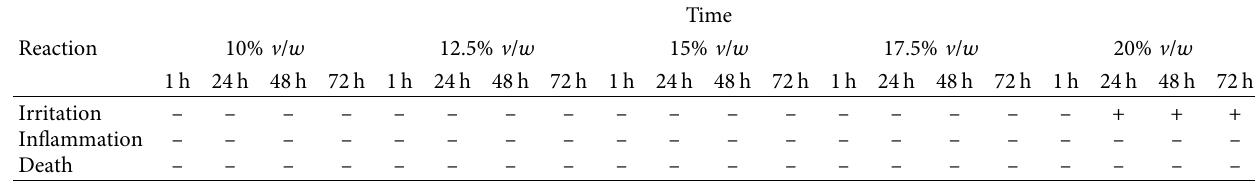
Table 5: Skin irritation tests of neem seed oil